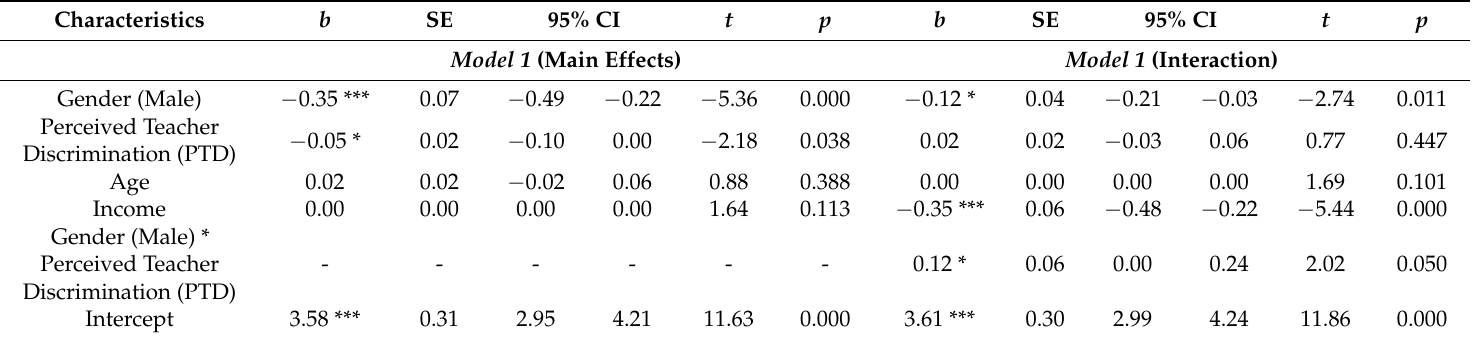
Table 2. Linear multivariable regression models in the overall sample of African American youth.